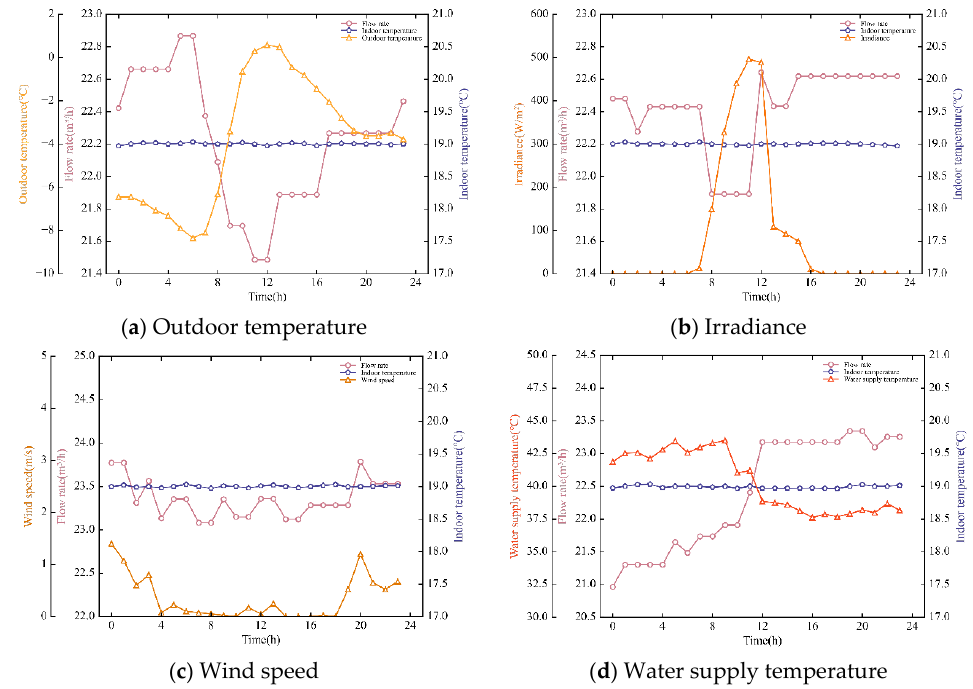
Figure 11. Variation in parameters under different disturbances in building B.